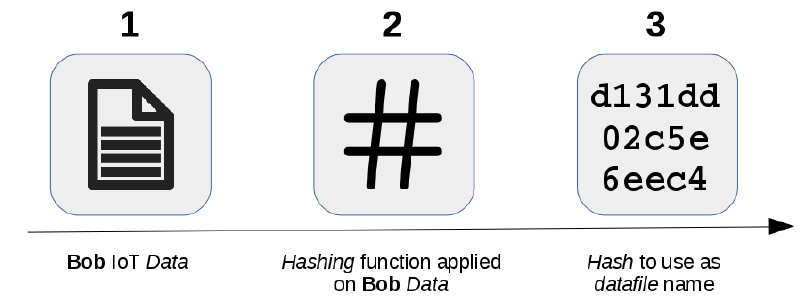
Figure 13. Data hashing